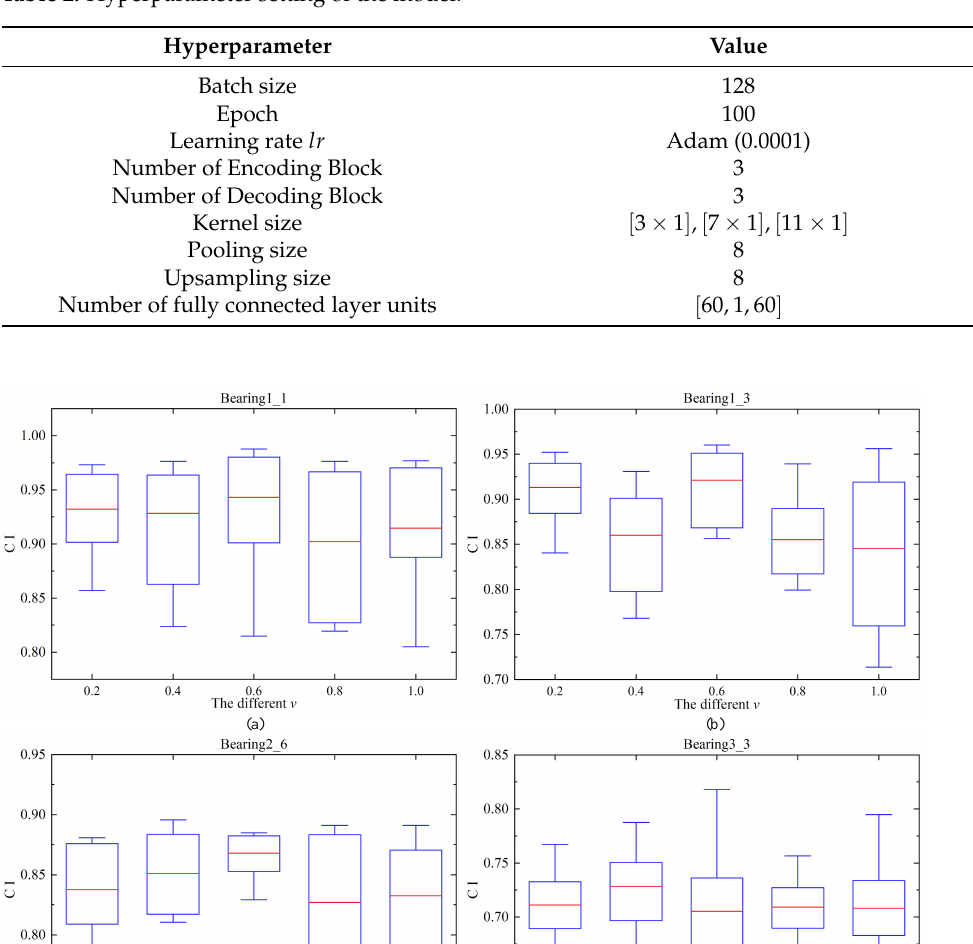
Figure 7. The details of MSCAE. Table 2. Hyperparameter setting of the model.